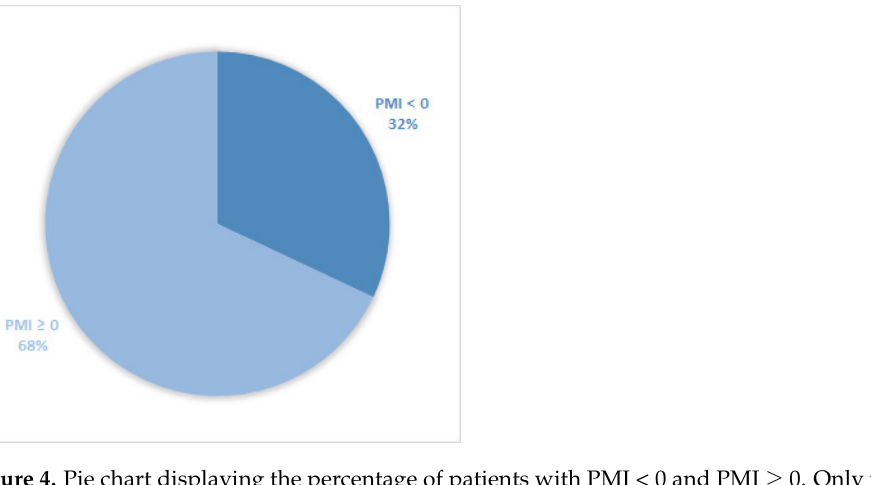
Figure 4. Pie chart displaying the percentage of patients with PMI < 0 and PMI ≥ 0. Only patients undergoing curative radiotherapy were included (1313).